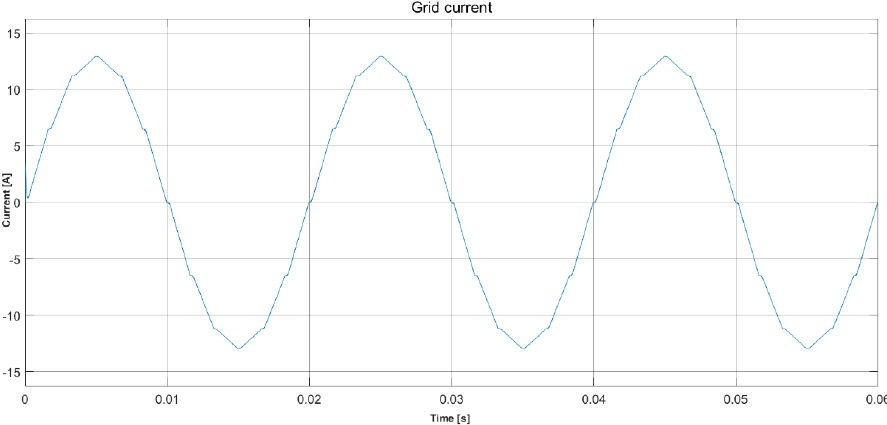
Figure 8. The waveform of the grid current ( i L1 ) drawn by the rectifier with the current modulator (the current modulator is based on the H-bridge with the output filter).